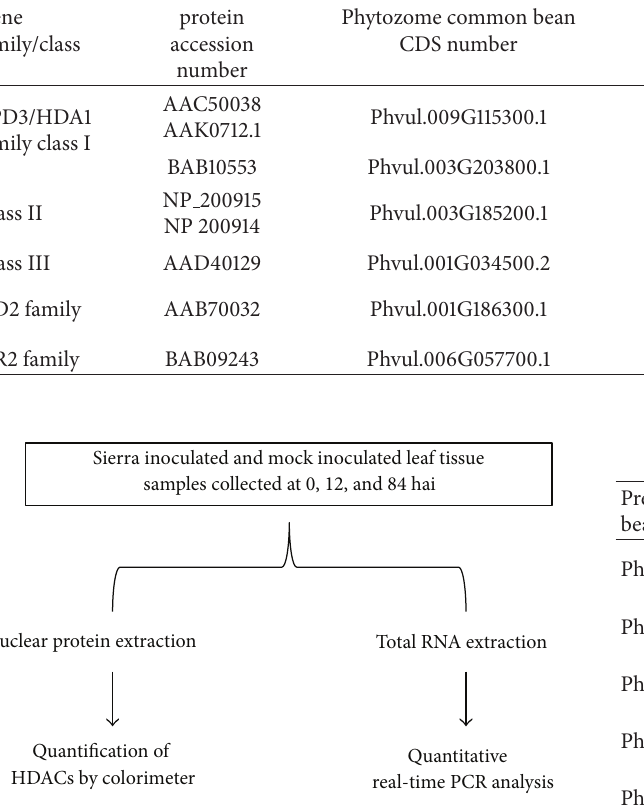
Figure 2: Flowchart outlining the experiment in this study. Same sets of materials from each biological replicate were utilized to perform colorimetric analysis and gene expression studies.